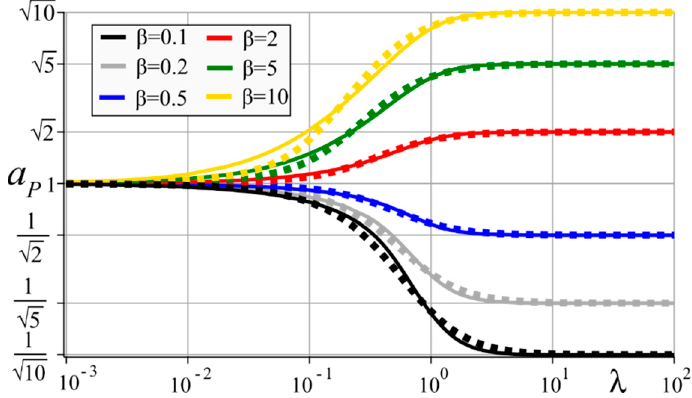
Figure 4. Relative contact radius a P for the homogeneous coatings calculated with N >> 1 (solid lines) and N = 1 (dashed lines). Mathematics 2020 , 8 , x FOR PEER REVIEW